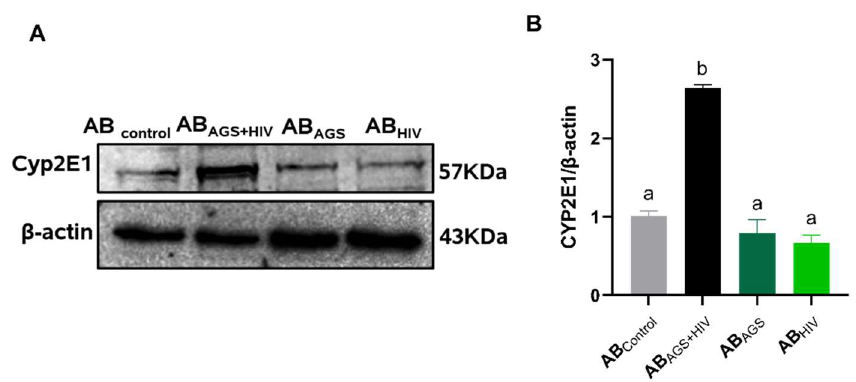
Figure A1. ABs derived from acetaldehyde and HIV-exposed RLW cells. (A) Upregulation of CYP2E1 (B) Quantification of the immunoreactive bands of CYP2E1. Data are from 3 independent experiments presented as mean ± SEM. Bars marked with the same letter are not significantly different and bars with different letter are different from each other ( p ≤ 0.05).